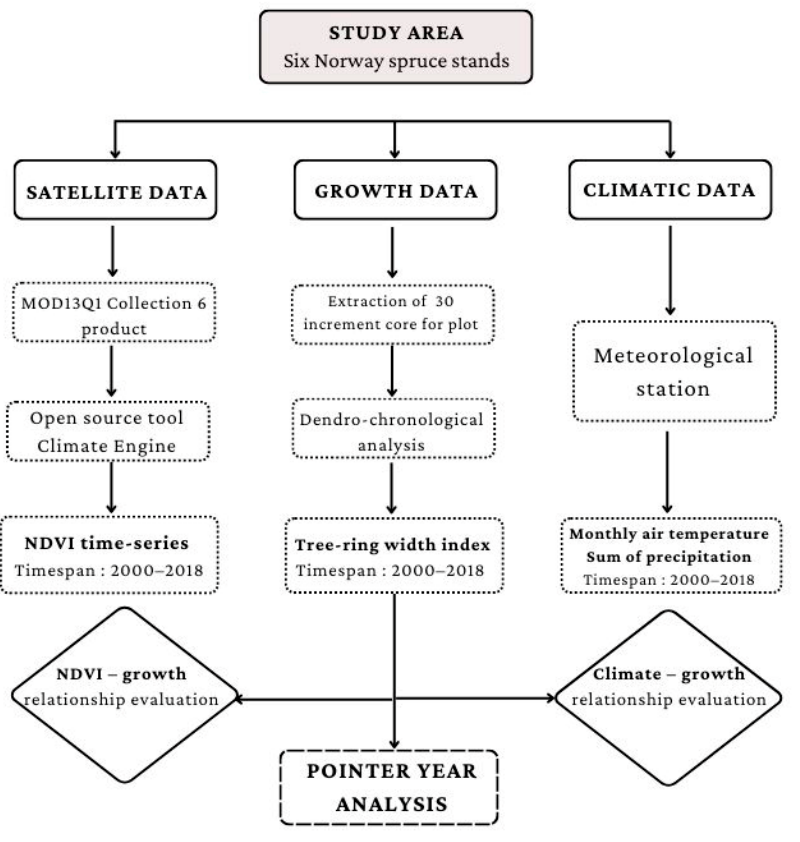
Figure 3. Flowchart covering methodology.